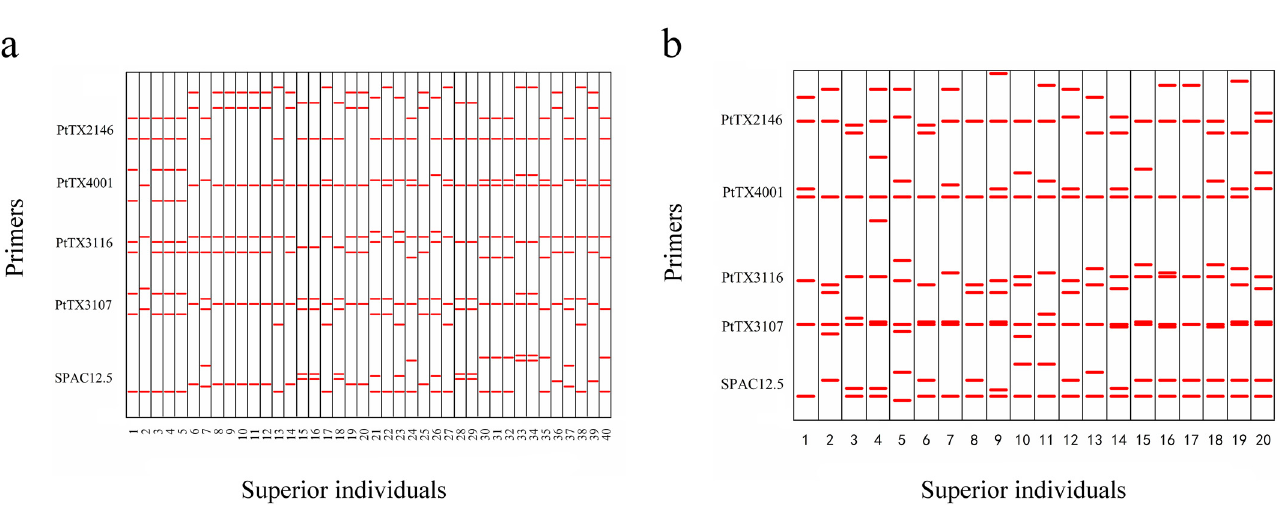
Fig 2. Fingerprints of five simple sequence repeat (SSR) primers in the second-generation ZN-NP (a) and XX-OP (b) selected populations of Chinese pine.